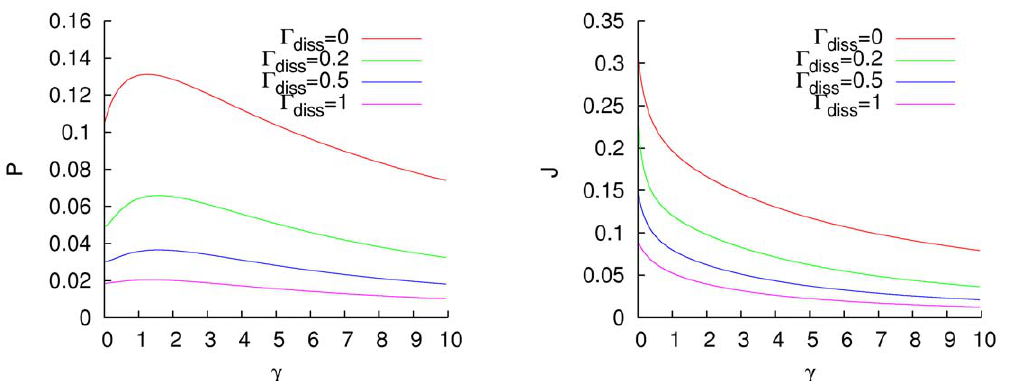
Figure 1. Excitation (left) and energy (right) fluxes for a homogeneous fully connected network, with B v i ~ B g ij ~ 1cm { 1 V i , j , as functions of the dephasing ratio c , for a low-temperature thermal bath, n ~ 1 , and different dissipation rates C diss . Units of cm { 1 .